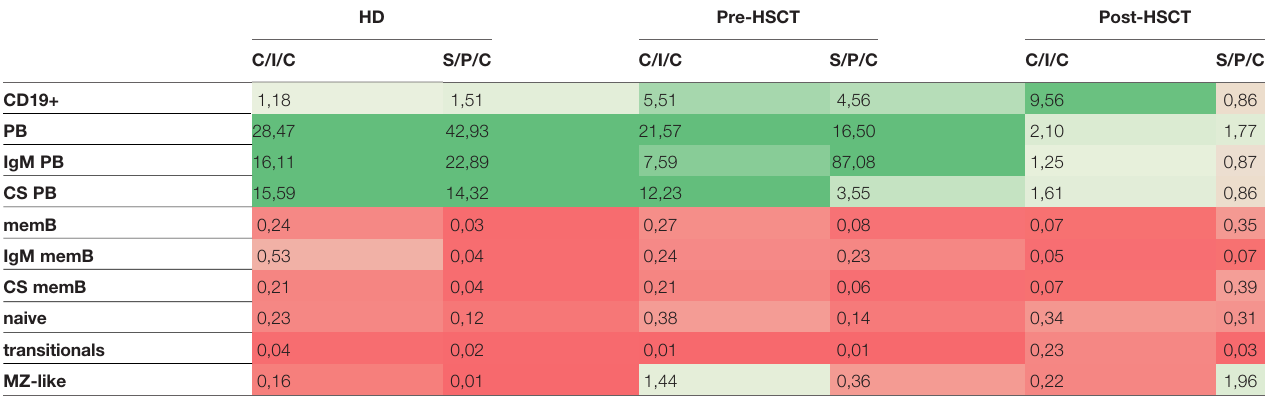
TABLE 1 | Median induction rates of B cell populations upon C/I/C or S/P/C